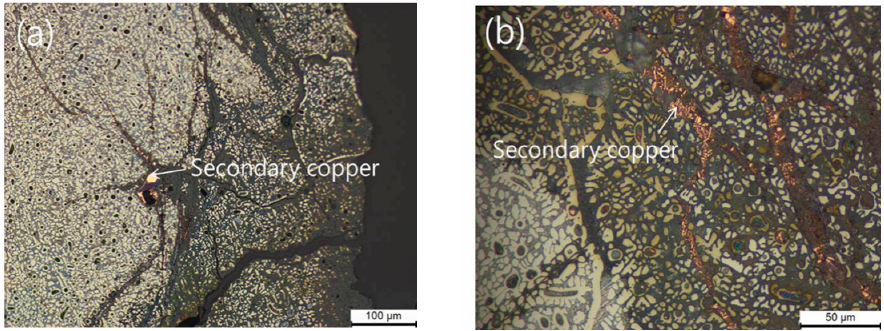
Figure 2. ( a ) Ga-2 (No. 1) optical micrograph showing secondary copper formed in cracks and ( b ) secondary copper formed in the corroded ( α + δ ) phase.